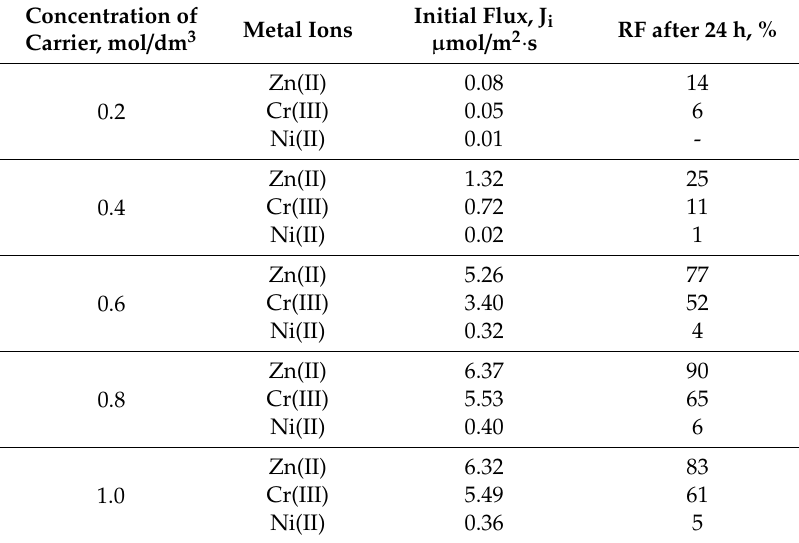
Table 3. Permeability coe ffi cients for transport of metal ions through membrane doped with EDAB-acac and recovery factor of metal after 24 h; membrane: 2.7 cm 3 o-NPPE / 1g CTA; feed phase: [M n + ] = 0.001 mol / dm 3 each, pH = 7.8, receiving phase: deionized water, pH =